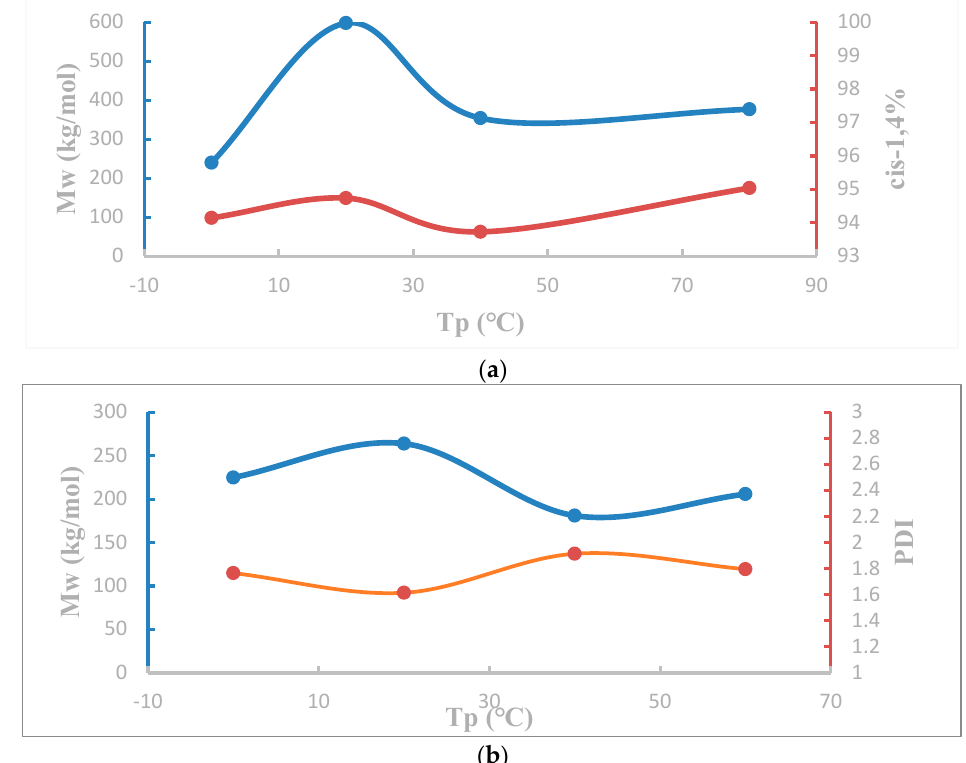
Figure 4. Influences of polymerization temperature on the molecular weight, molecular weight distribution and cis-1,4 content. ( a ) Temperature effect on Mw and cis -1,4 content for materials from 3 -MMAO3A in hexane; ( b ) temperature effect on Mw and DPI for materials from 3 -MMAO3A in toluene.